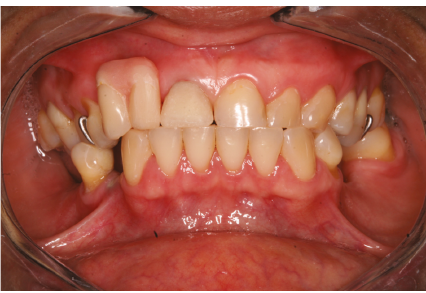
Figure 3: Removal of the implant with a retrieval tool.